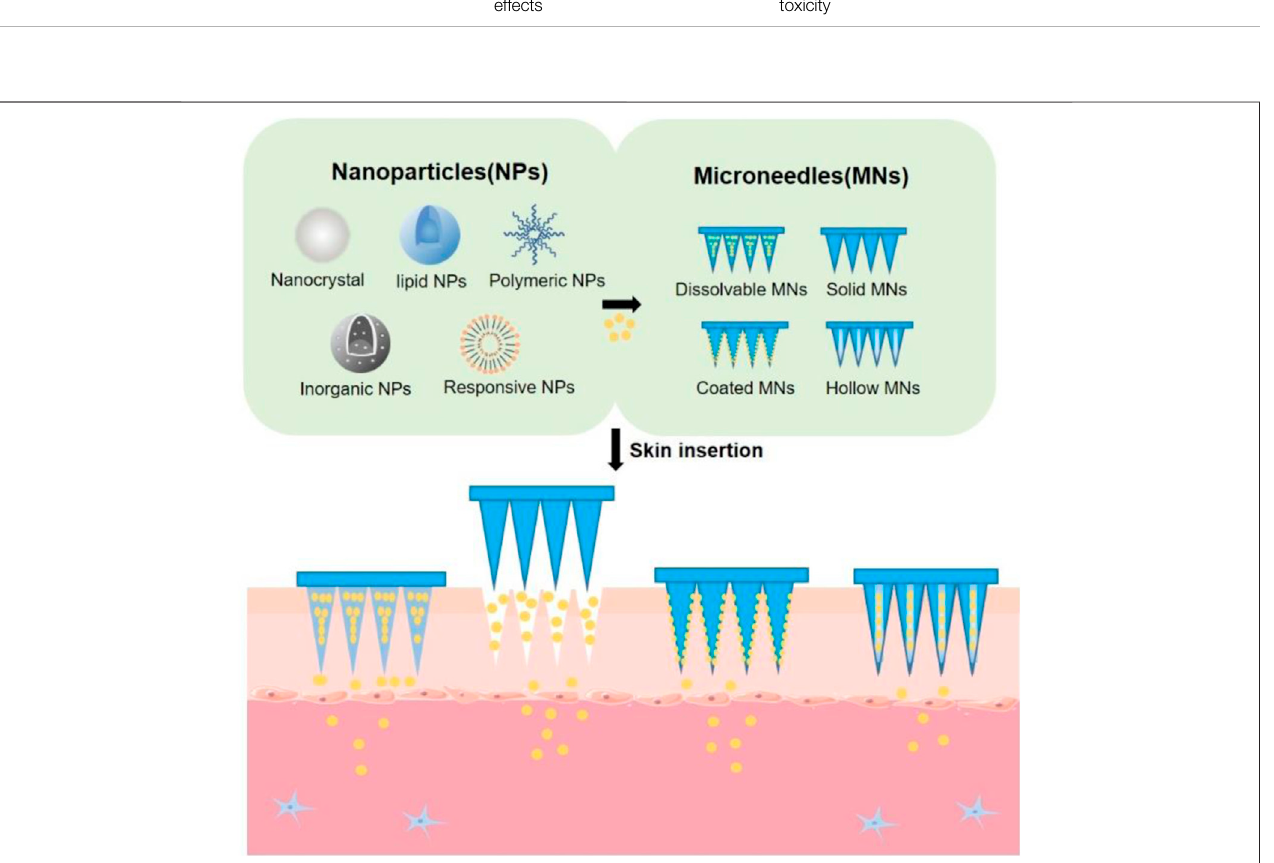
FIGURE 1 | The schematic illustration of MNs-mediated transdermal delivery of nanoparticles.